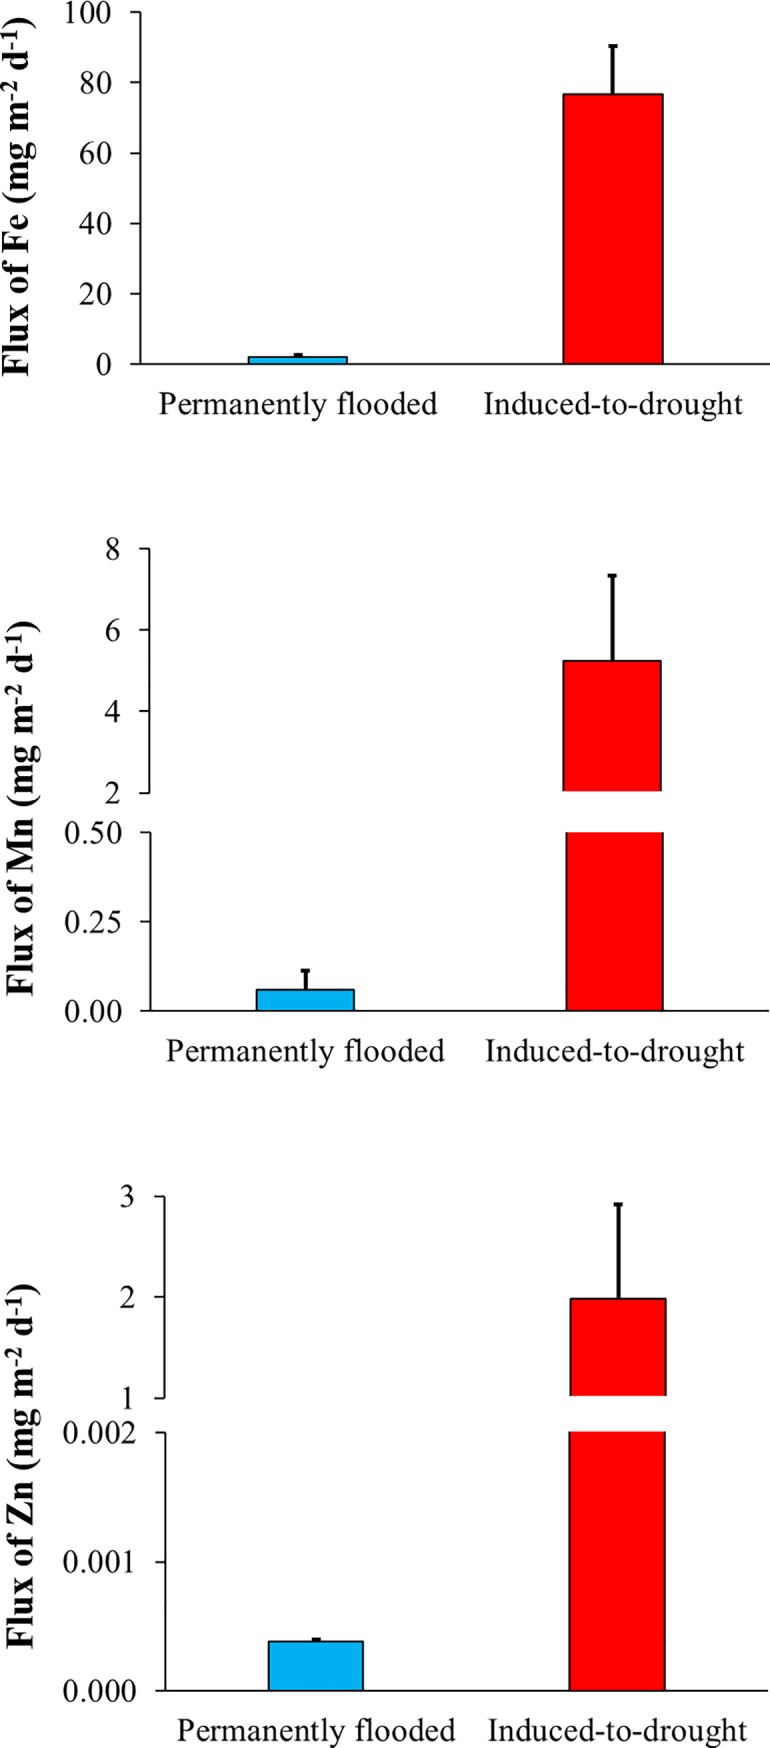
Average ± standard error of Iron (Fe), Manganese (Mn) and Zinc (Zn) release rates (mg m-2 d-1) from permanently flooded (blue) and induced-to-drought cores (red) during the rewetting period.For a better view of results, only the upper standard error is shown.